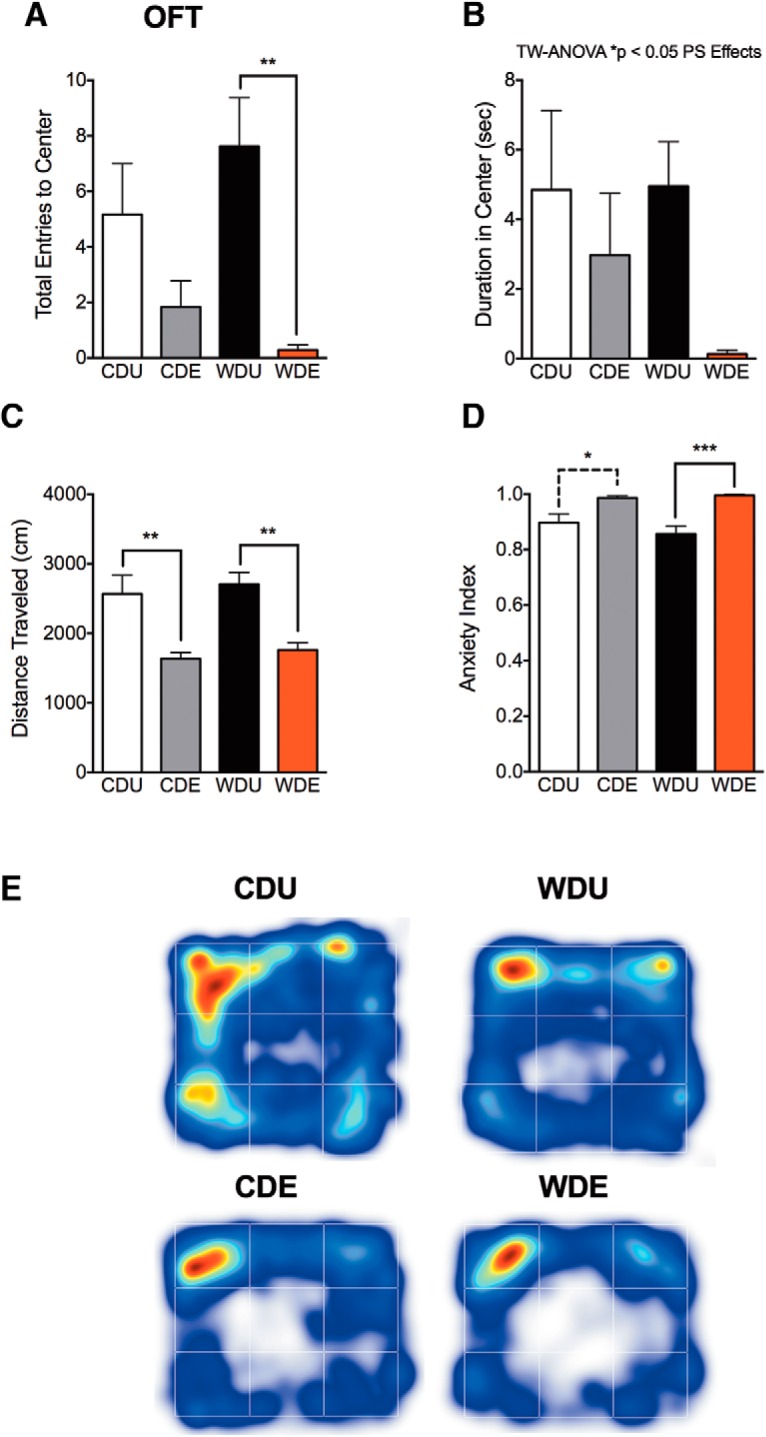
WD confers vulnerability to OFT anxiety-like behaviors following traumatic stress exposure. A, PS exposure reduced the number of entries to the center of the OFT (PS: F(1,23) = 14.48, p = 0.0009; diet: F(1,23) = 0.11, p = 0.75; diet × PS interactions: F(1,23) = 2.04, p = 0.17). Post hoc comparisons indicated that the effect of PS was particularly robust in WDE rats when compared with WDU controls (Tukey’s test adjusted, p = 0.0036). B, ANOVA revealed that PS decreased the duration in the center (F(1,23) = 5.02, p = 0.035), while diet (F(1,23) = 0.83, p = 0.37) and diet–PS exposure interactions (F(1,23) = 0.97, p = 0.34) showed no significant main effects. C, PS exposure reduced the total distance traveled in the open field arena (F(1,23) = 32.85, p = 0.0001). Analyses revealed no significant main effect of the diet (F(1,23) = 0.37, p = 0.55) or diet–PS exposure interactions (F(1,23) = 0.049, p = 0.83) on locomotor activity in the open field arena. D, PS exposure increased indices of anxiety on the OFT (PS: F(1,23) = 25.97, p < 0.0001). The main effects of the diet (F(1,23) = 0.37, p = 0.55) and diet–PS exposure interactions (F(1,23) = 1.35, p = 0.26) showed no statistical significance on the OFT anxiety index. E, OFT heat map analyses show that thigmotaxis was particularly robust in the WDE group. All data are presented as the mean ± SEM. *p < 0.05, **p < 0.01, n = 6–10 rats/group.